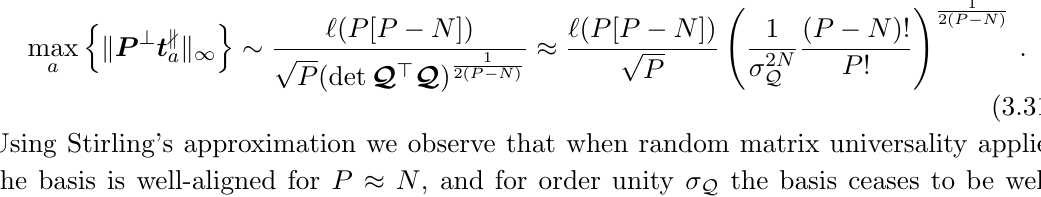
Figure 9 . Ensemble average of largest phase (3.28) as a function of P , with N = 20 and (cid:27) 2 The solid line is the estimate